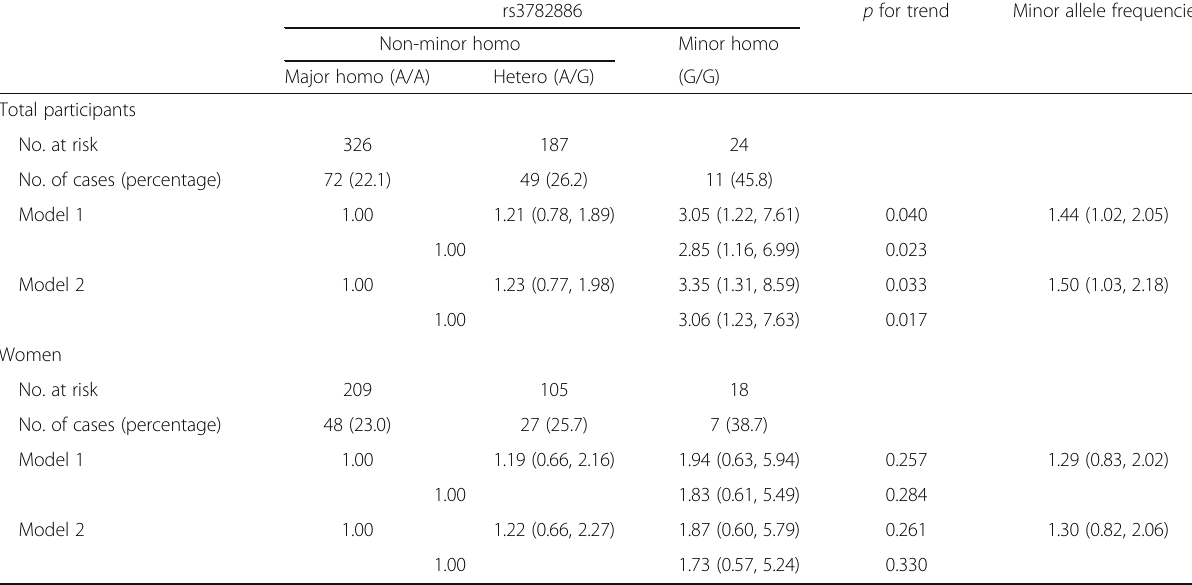
Table 3 Odds ratios (OR) and 95% confidence intervals (CI) for short stature in relation to rs3782886 genotype rs3782886 p for trend Minor allele frequencies Non-minor homo Minor homo